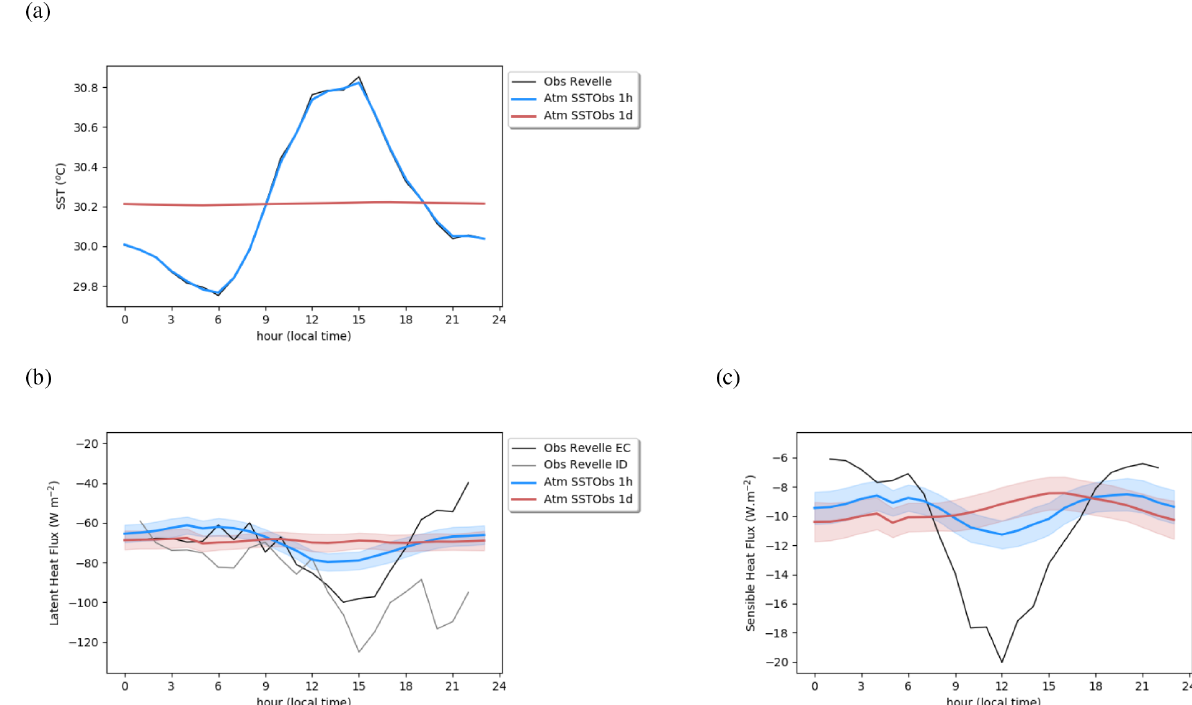
Figure 6. Mean daily cycle of (a) surface temperature ( ◦ C), (b) surface latent heat flux (Wm − 2 ), and (c) surface sensible heat flux (Wm − 2 ) averaged over the simulated period (13–22 November) for the atmospheric experiments and observed estimates. The shading represents 2 standard deviations of the inter-member ensemble.